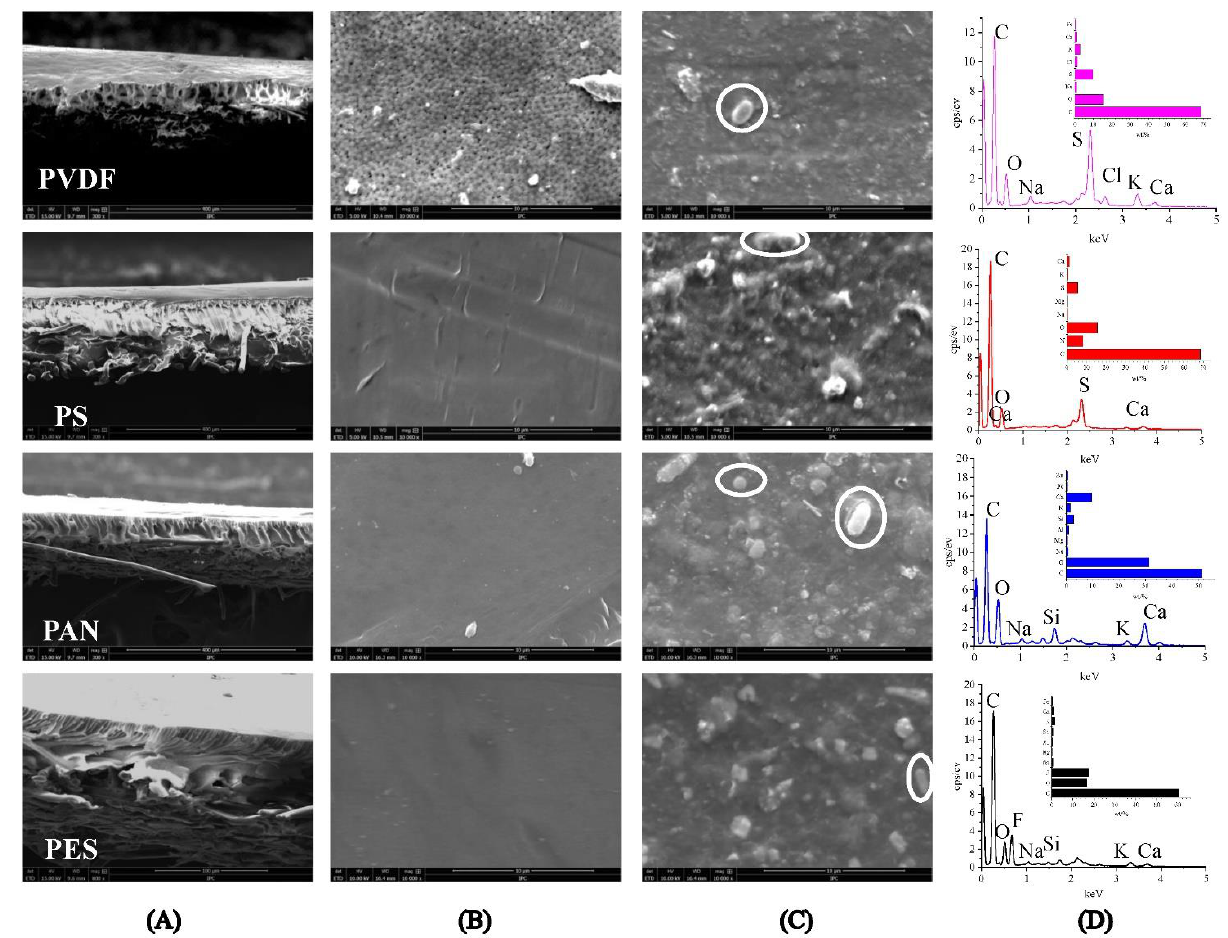
Figure 4. SEM images of: ( A ) Cross-sections of UF membranes (×800); ( B ) virgin membrane surface (×10,000); ( C ) fouled membrane surface (×10,000), microbes were identified by white circle; ( D ) EDS of pollutants.